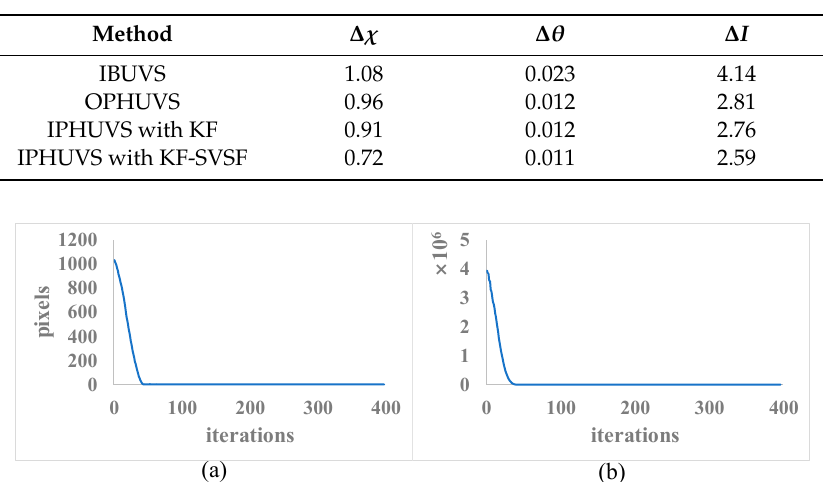
Figure 14. Detailed result of the improved PHUVS with the KF-SVSF method in the static positioning experiment. ( a ) Image error norm. ( b ) Norm of error vector.